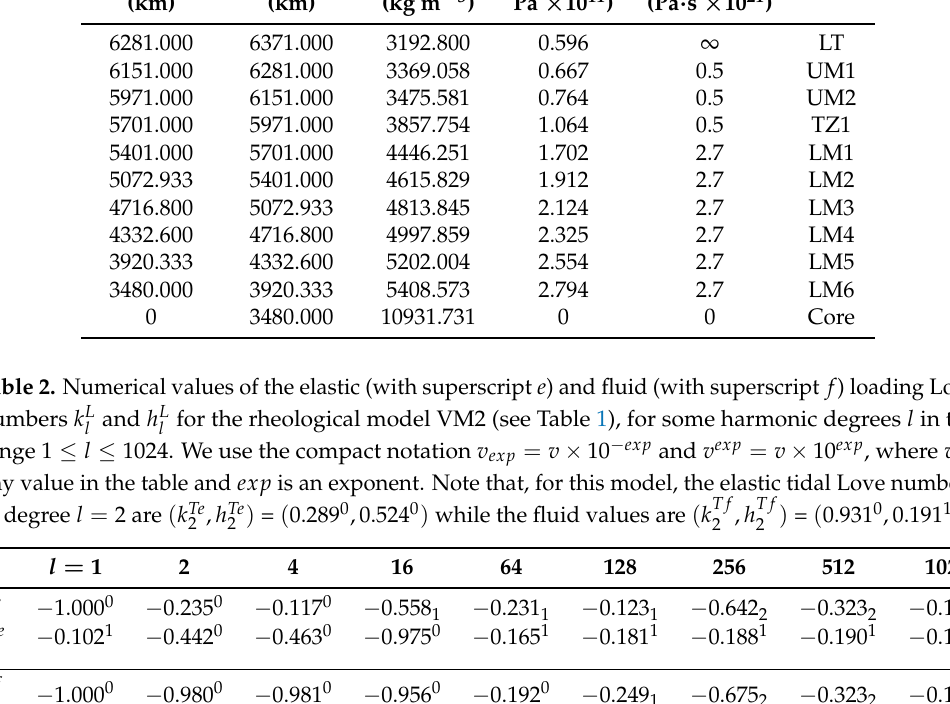
Table 1. Values of density, rigidity and viscosity adopted in our realization of the rheological model VM2, with abbreviations LT, UM, TZ and LM denoting the lithosphere, the upper mantle, the transition zone and the lower mantle, respectively. With r and r + we denote the radii of the base and of the top − of each layer. A few spectral properties of this model are shown in Table 2.